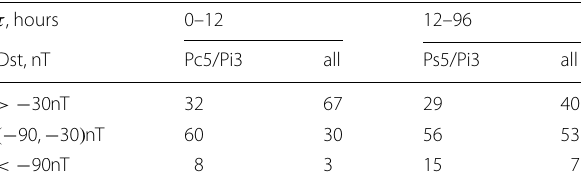
Table 2 Distribution of the selected and all intervals over Dst (% of the total